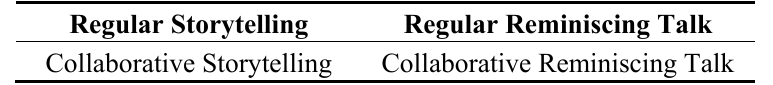
Table 2. All participants participated in the following four conditions in counterbalanced